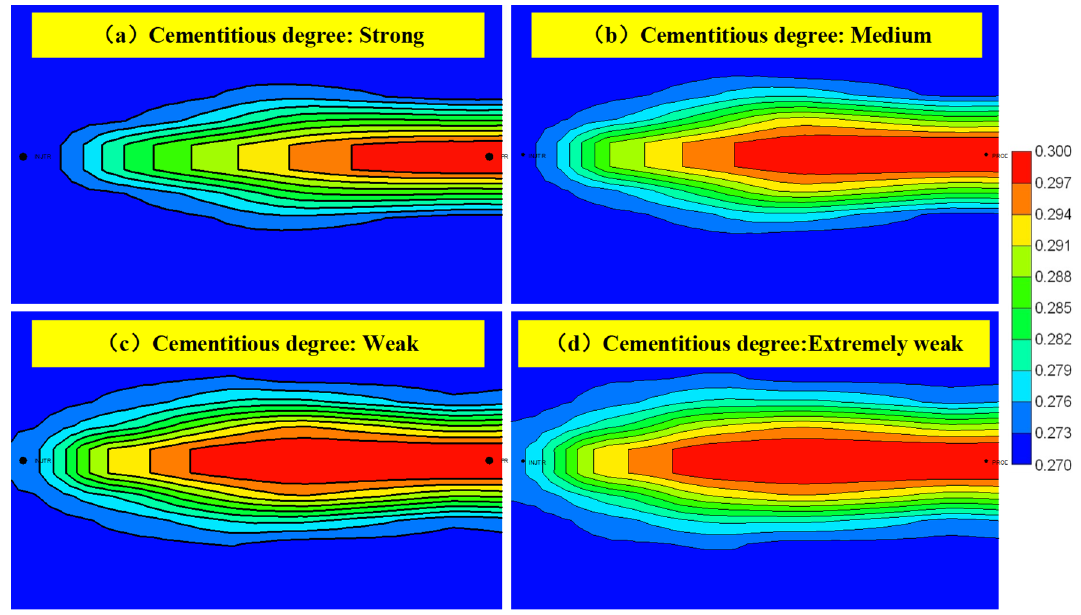
Figure 17. Porosity distribution after steam flooding at different cementation